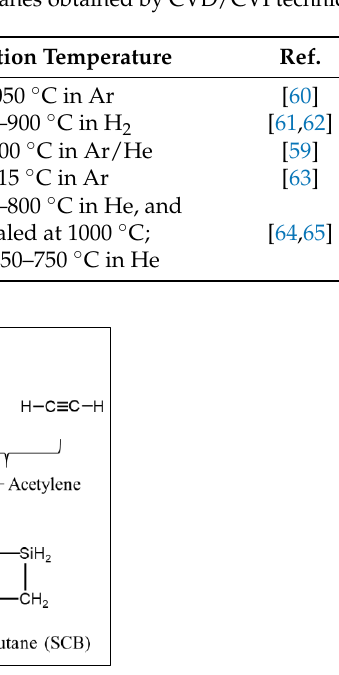
Figure 4. Structures of typical precursors used in CVD/CVI techniques.